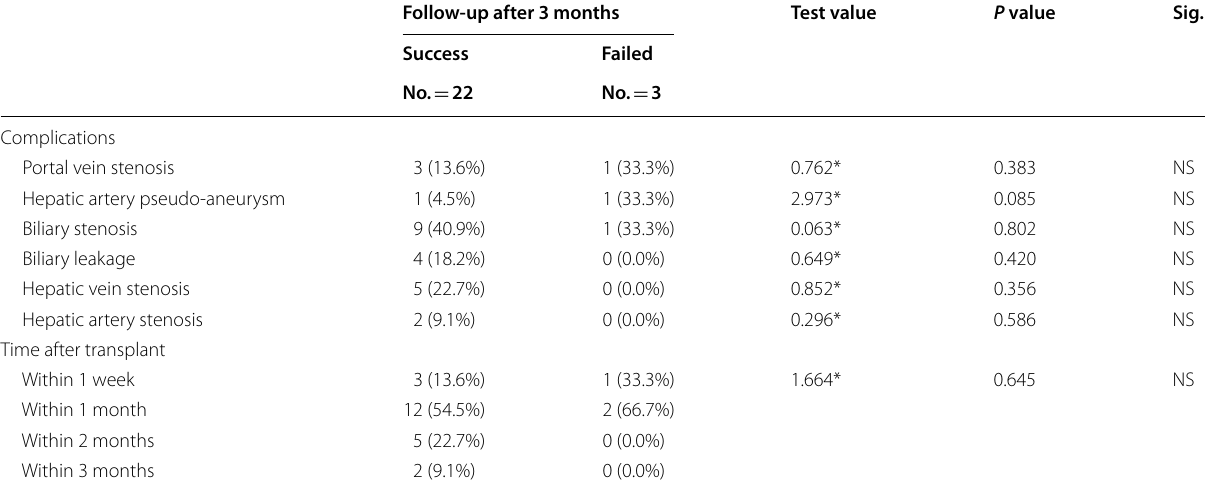
Table 2 The relation between the complication, time after transplant, and the outcome after 3‑month